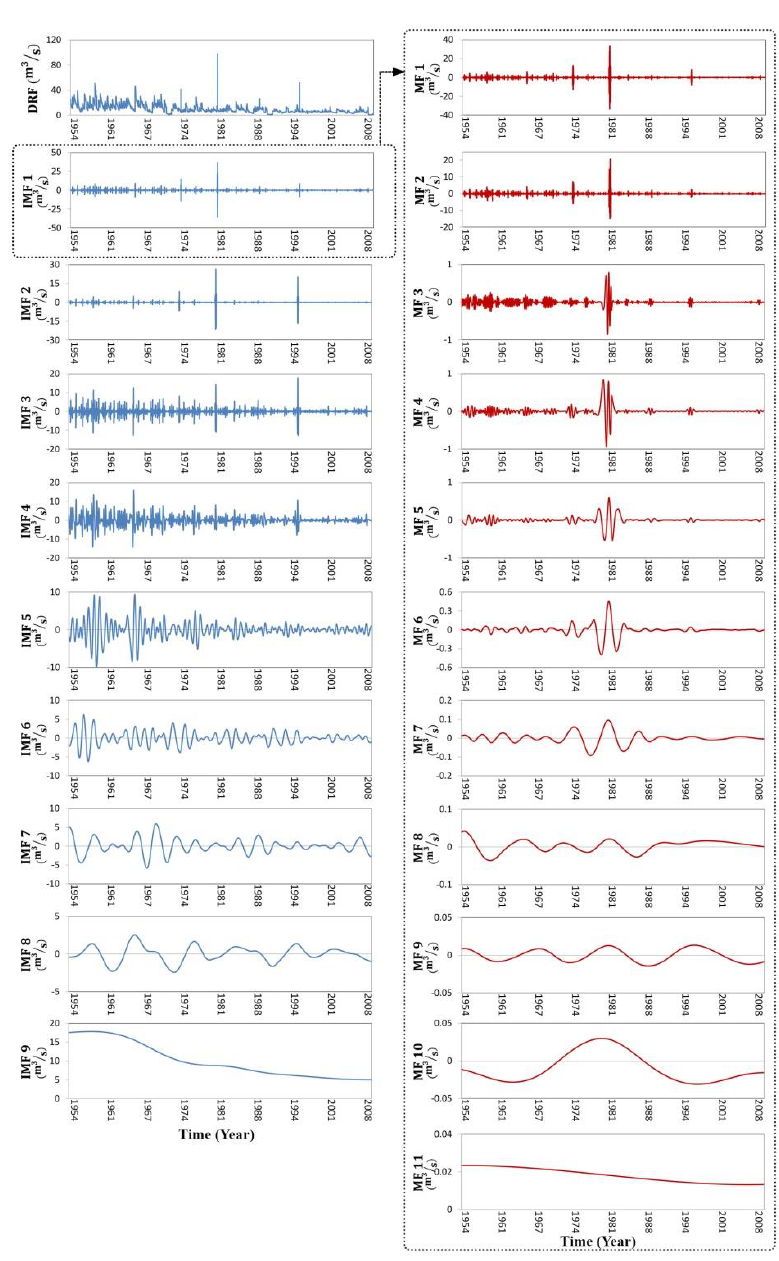
Figure 5. Ensemble empirical mode decomposition (EEMD) (Blue line) and variational mode decomposition (VMD) (Red line) of daily streamflow time series at the Siira station.